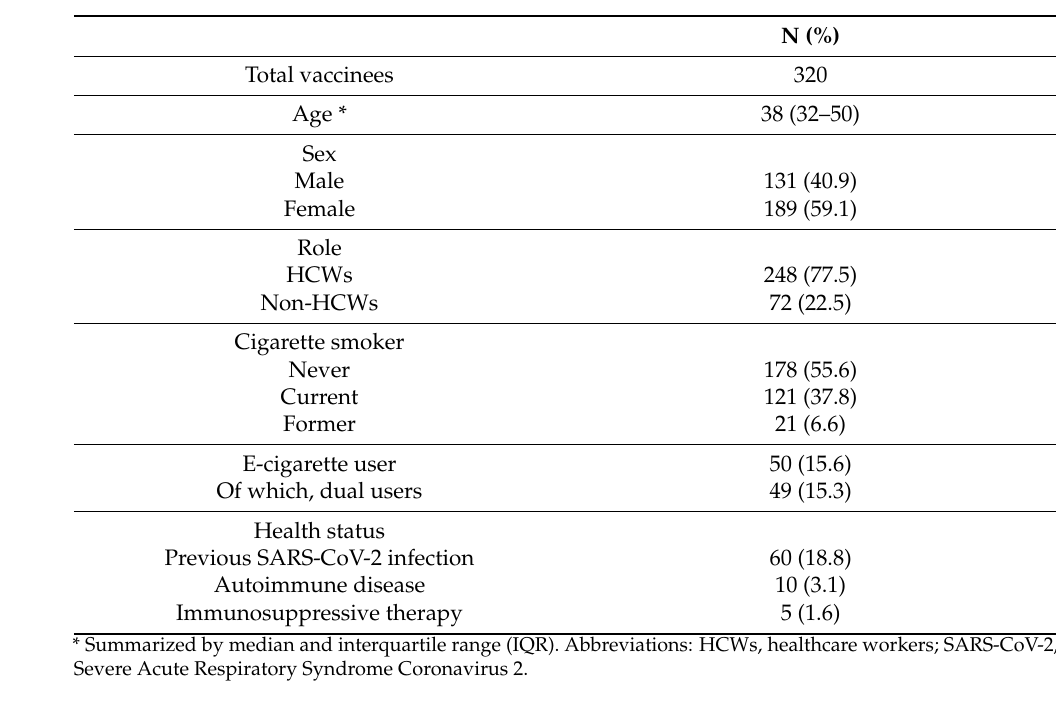
Table 1. Study population.